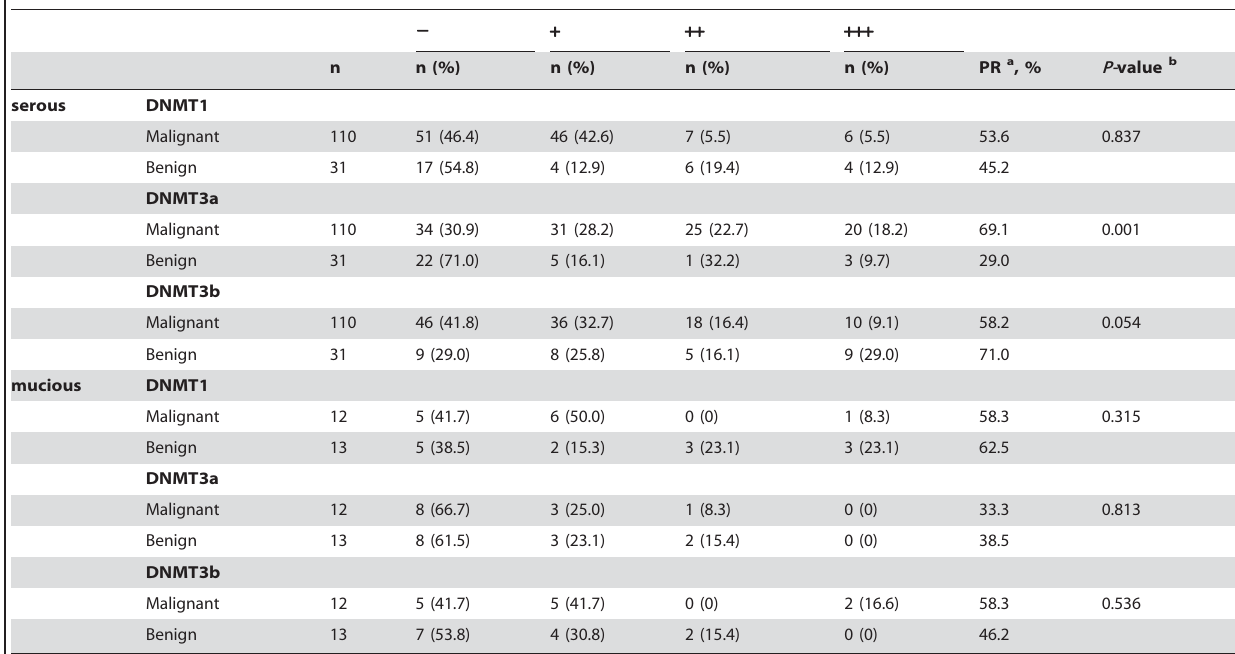
Table 2. DNMTs expression in malignant and benign ovarian